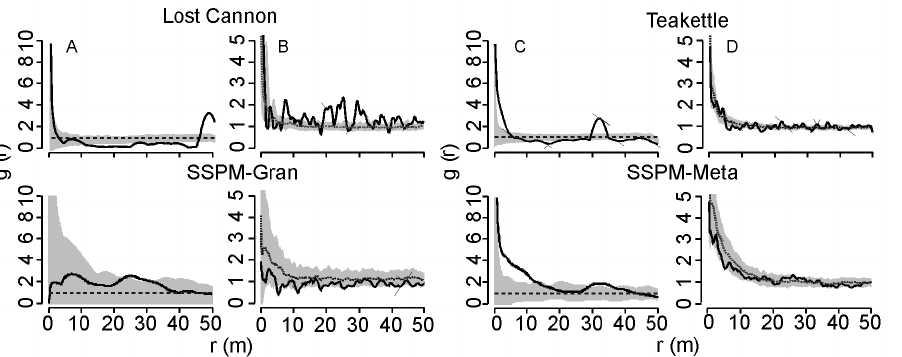
Figure 6. Comparison of the observed (solid lines) spatial distribution of snags (A and C) and snags with live trees (B and D). The inhomogeneous pair correlation function with an Epanechnikov smoothing kernel was used for Lost Cannon and Teakettle. Approximately 95% Monte Carlo simulation envelopes (grey shaded areas) were constructed with the null model of random mortality.